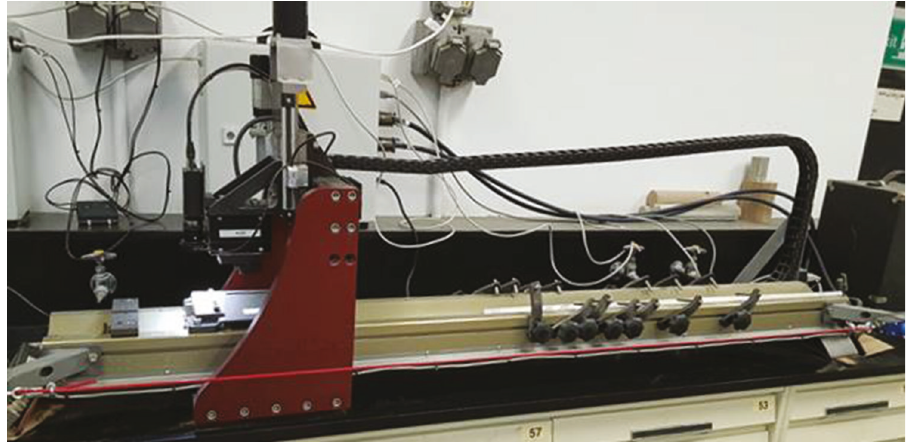
Figure 2: An overview of the scratch test machine used in this study.